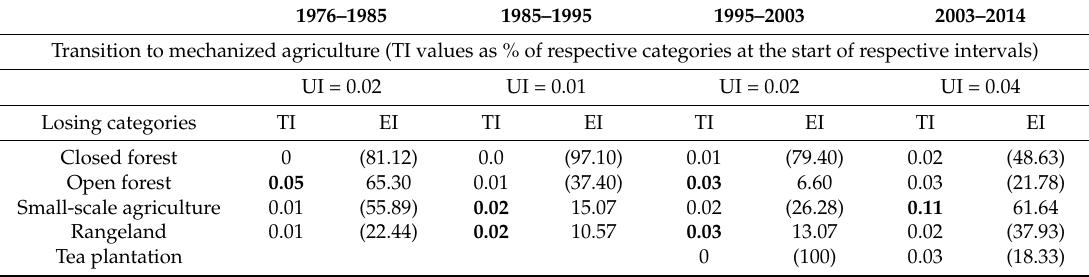
Table 3. Land-use transitions between categories with special focus on the expansion of agriculture.